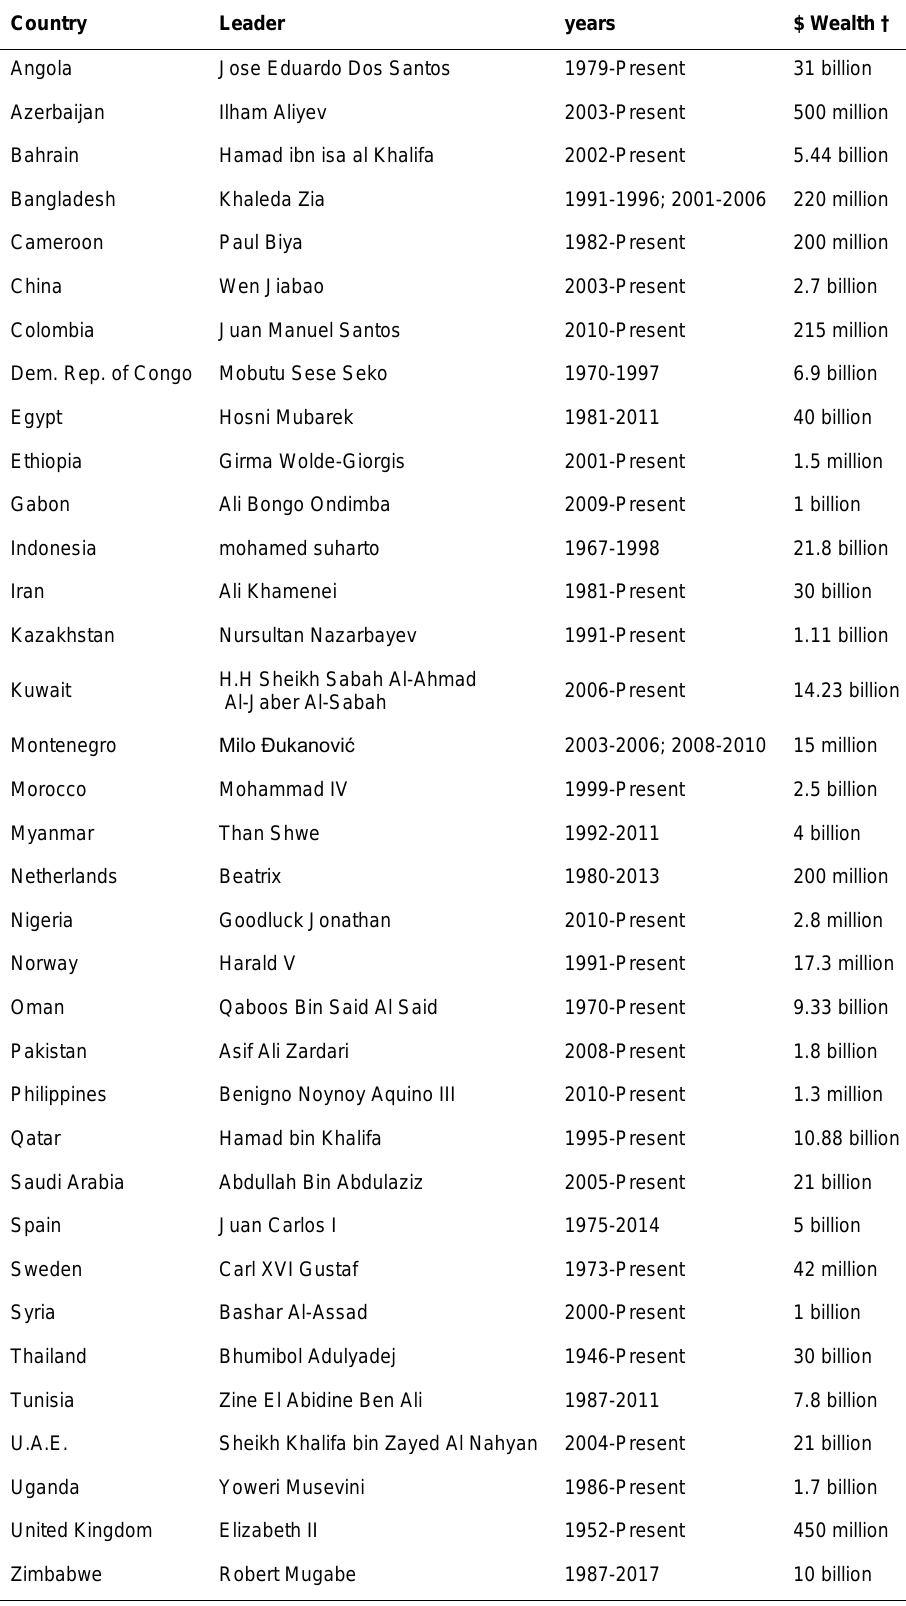
Table 1. List of